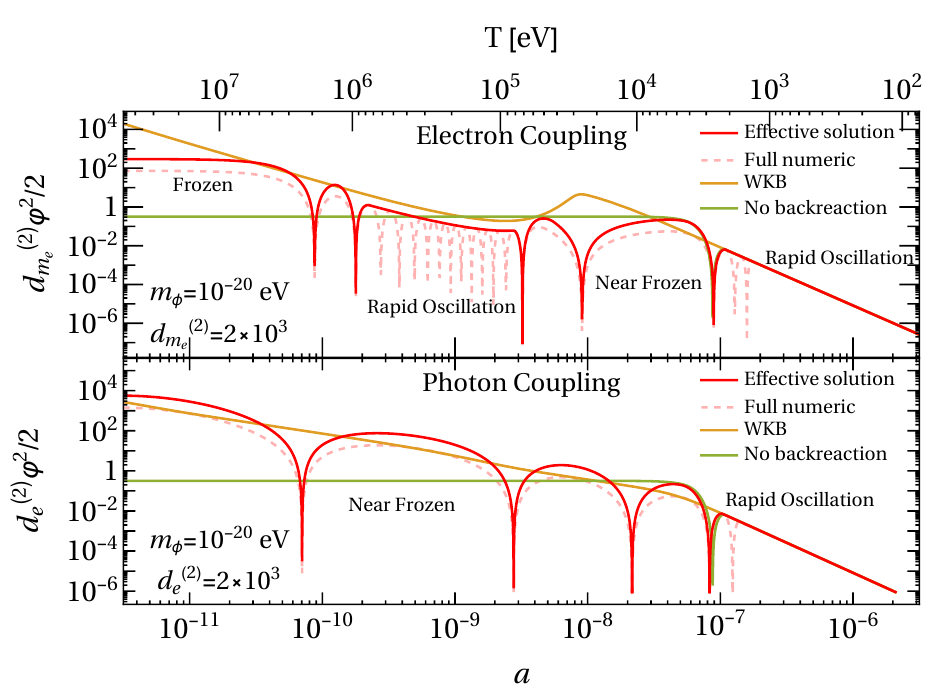
Figure 1 . The evolution of the DM coupled to electrons (upper) or photons (lower). The effective solution is a splice of the numerical solution and the WKB approximation. The thermal mass used for the photon evolution was computed in the high-temperature limit as explained in section